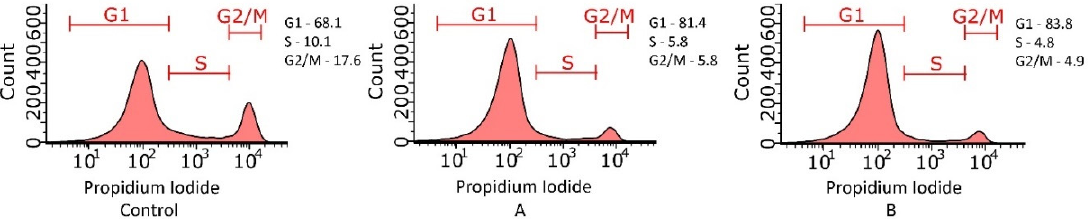
Figure 9. Effect of 3f on cell cycle progression of M-HeLa by flow cytometry. ( A ) M-HeLa cells were treated with the